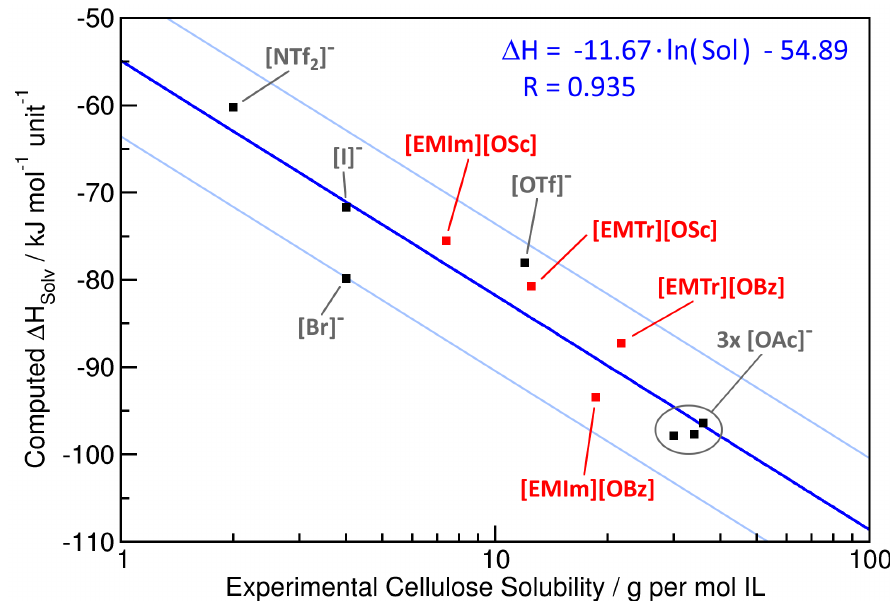
Figure 6. Correlation of the experimental cellulose solubility with the predicted enthalpy of solvation ∆ H Solv . The red data points correspond to the four ILs from this study, while the black points are taken from our recent article [38]. The blue curve is a regression function (equation in axis units and correlation coefficient R; see the upper right corner), and the two light blue curves depict a range of a factor of two deviation in predicted cellulose